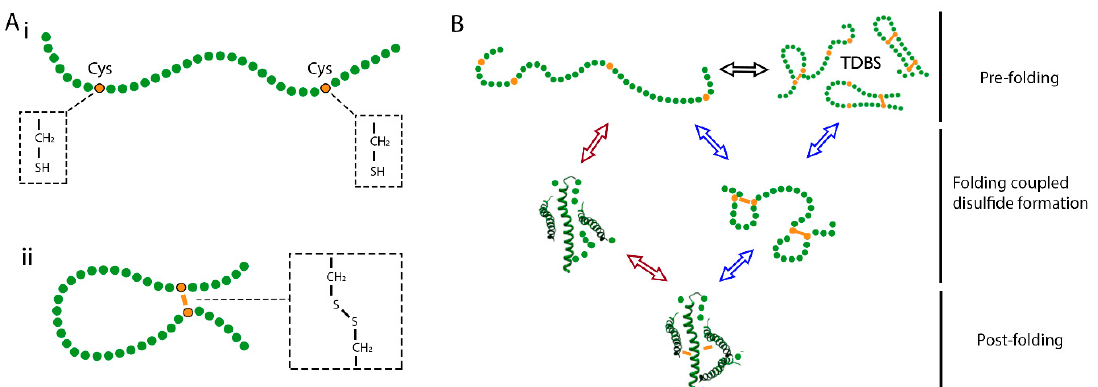
Figure 1. Disulphide bond formation and conformational folding. ( A ) Schematic diagram of a nascent polypeptide, with the molecular structure of cysteine sidechains highlighted before ( i ) and after ( ii ) disulphide bond formation. ( B ) Mechanistic scheme to describe folding coupled disulphide formation. At the pre ‐ folding stage, the nascent polypeptide exists as a dynamic random coil, in which disulphide interchange can take place to form transient disulphide bonded species (TDBS). If folding follows the folded precursor mechanism (red arrows), then formation of the nascent tertiary structure occurs first and promotes native disulphide formation. If folding follows the quasi ‐ stochastic mechanism (blue arrows), then disulphide formation occurs first and drives the formation of the native tertiary structure. At the post ‐ folding stage, the native fold is complete, and disulphide bonds are buried and protected.